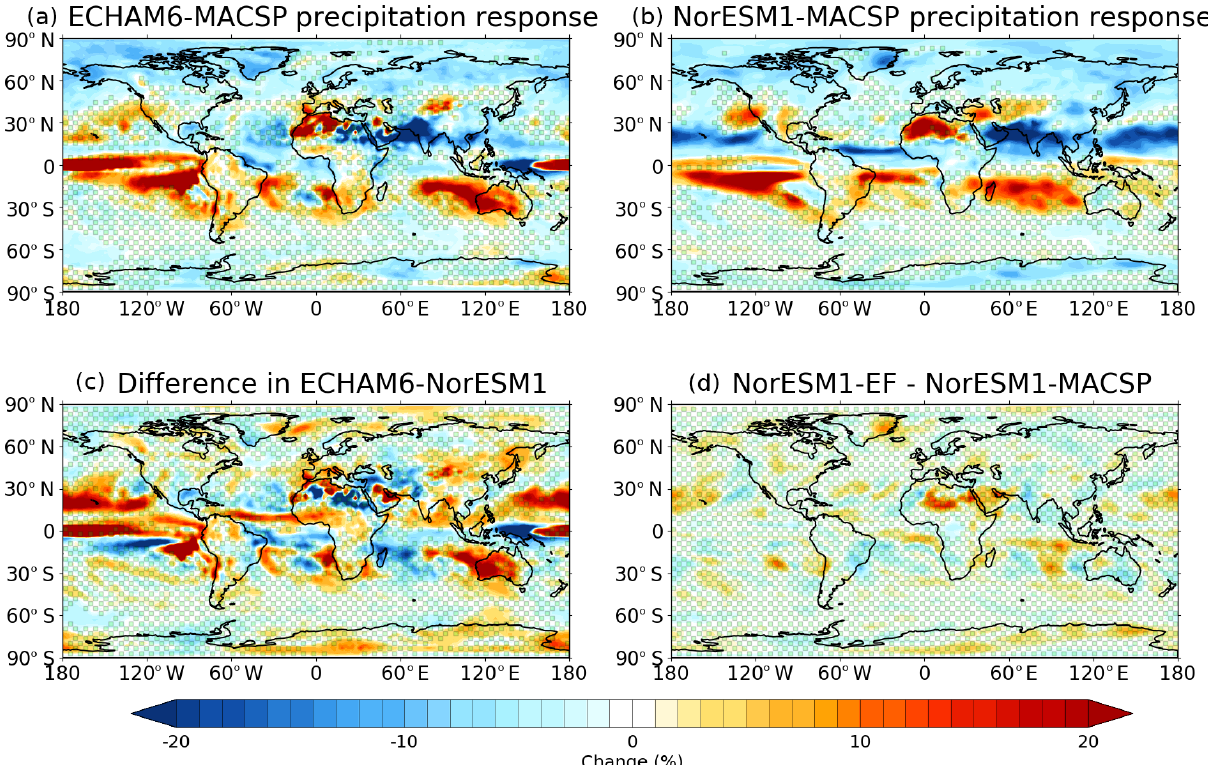
Figure 4. Panel (a) shows the ECHAM6-MACSP experiment precipitation response to adding MACv2-SP aerosols and (b) shows the same for the NorESM1-MACSP experiment. Panels (c) and (d) show the intermodel difference in precipitation response and difference between NorESM1-MACSP and NorESM1-EF. The green dots mark the regions where the MACv2-SP aerosols do not have a statistically significant impact at the p < 0 . 05